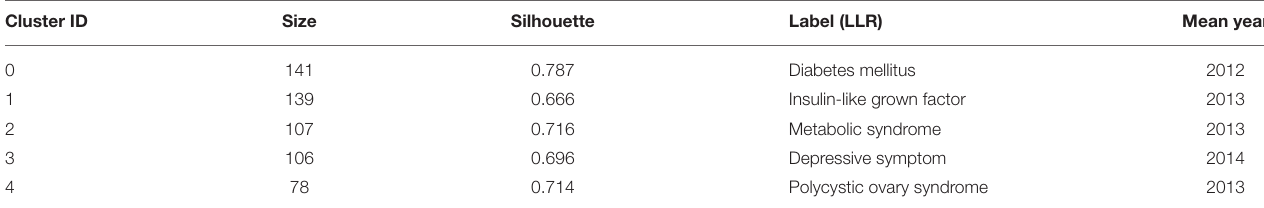
TABLE 5 | Keywords cluster analysis (the silhouette value is over